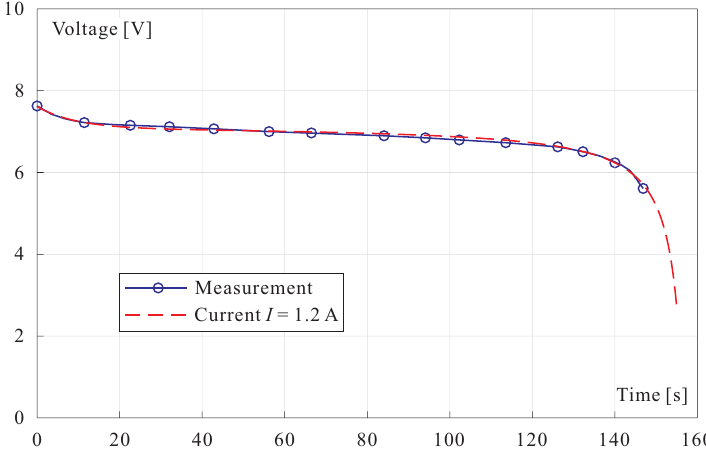
Figure 10. Discharge curve of two batteries B2 in series for a discharge rate of 1.2 A (data from manufacturer). The dashed line is the best fit Shepherd